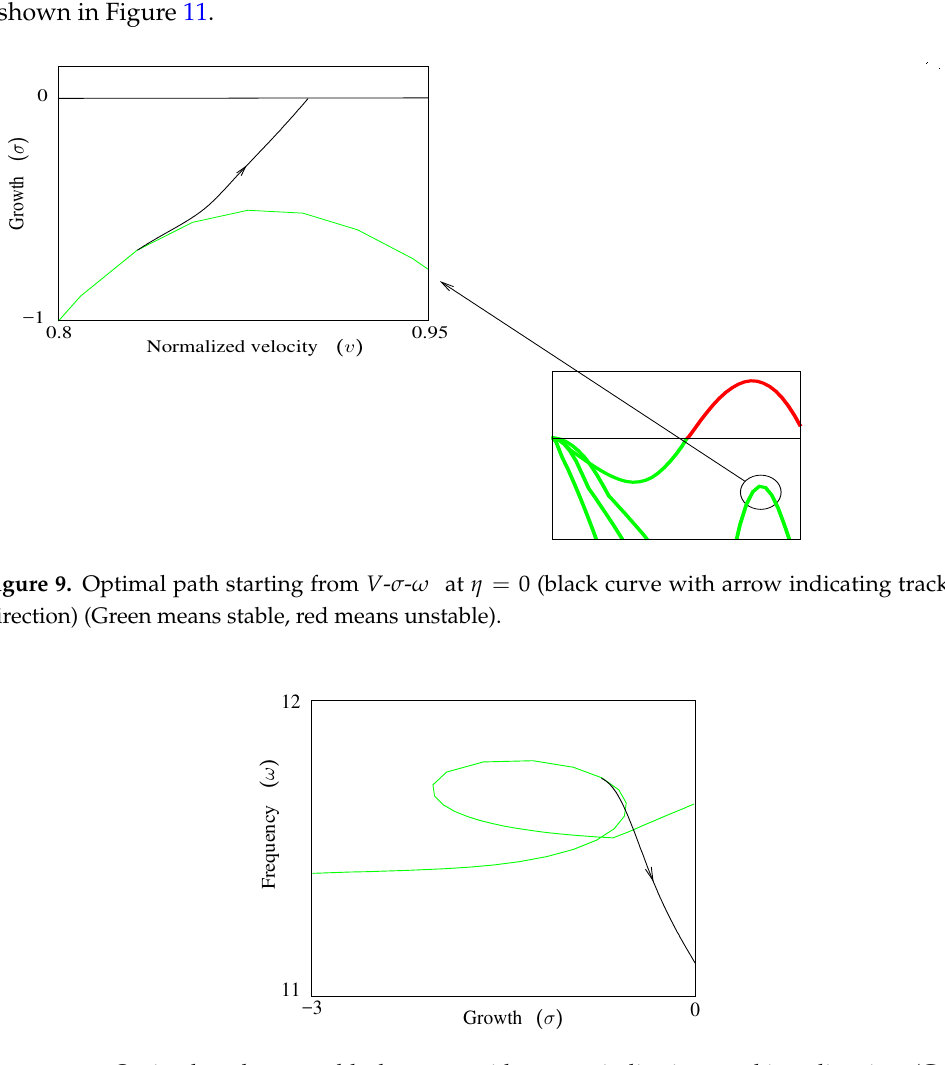
Figure 10. Optimal path: σ - ω , black curve with arrow indicating tracking direction (Green means